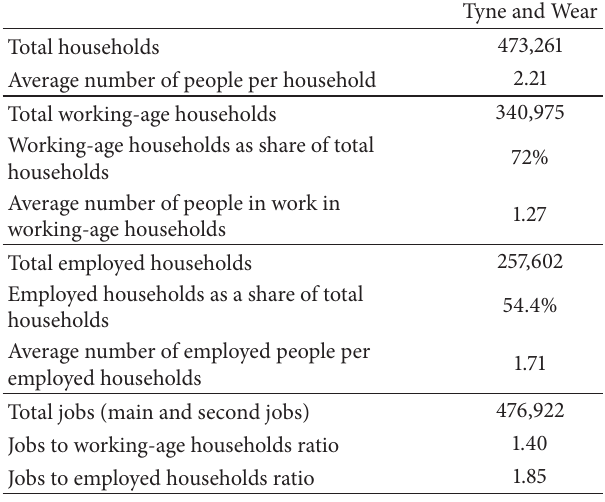
Table 1: Key employment and household data in Tyne and